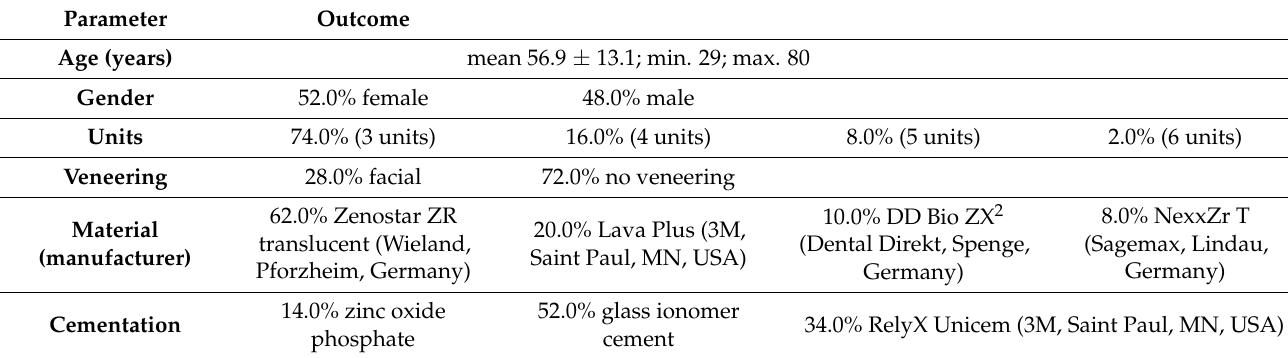
Table 1. Characteristics of the patient population and